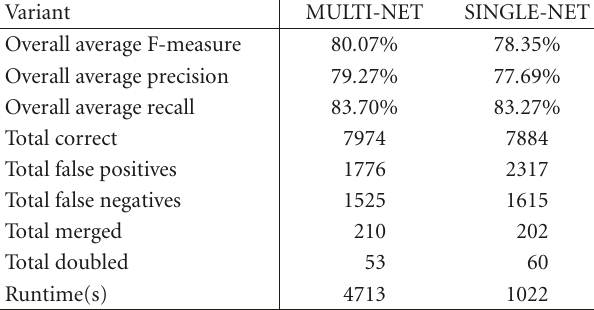
Table 5: Overall results of the MIREX 2005 onset detection contest for our two variants. Their F-measures were the two highest. They also had the best balance between the precision and recall. This is probably due to to the learned threshold in the peak-picking